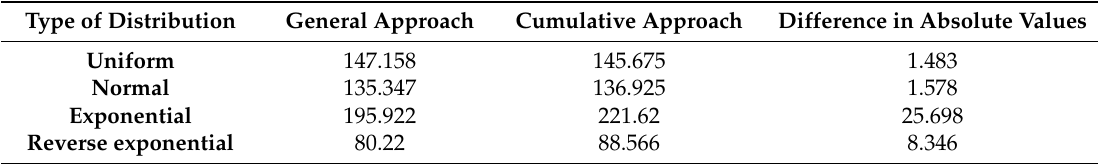
Table 8. Comparison of estimated total number of ASD trips per year.